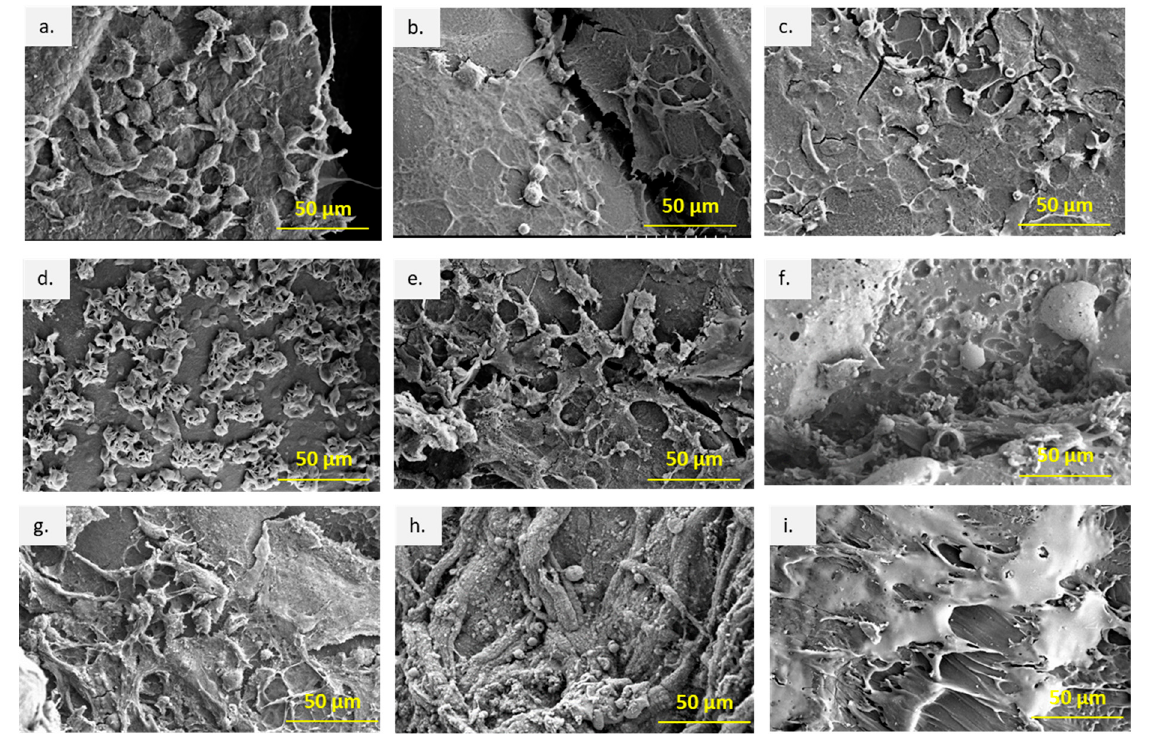
Figure 6. SEM images of the cells and tissues following subcutaneous implantation at different time points. ( a ) TPU at week 1, ( b ) TPU/PLA at week 1, ( c ) PLA at week 1, ( d ) TPU at week 4, ( e ) TPU/PLA at week 4, ( f ) PLA at week 4, ( g ) TPU at week 8, ( h ) TPU/PLA at week 8, and ( i ) PLA at week 8. Scale bar 50 µm.